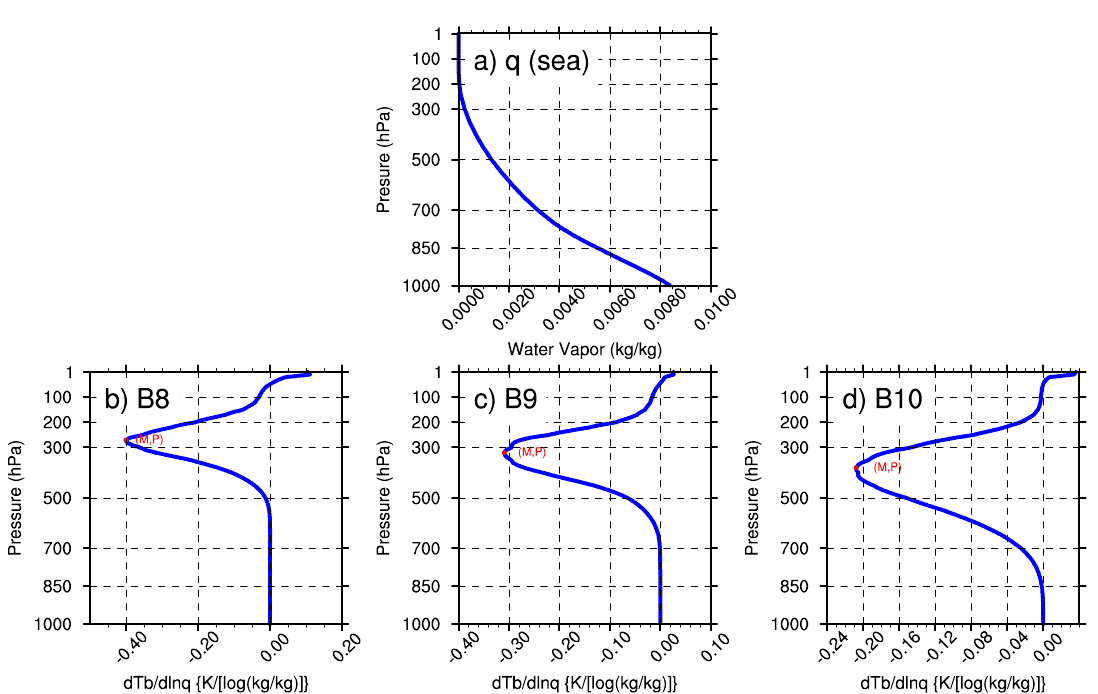
Figure 12. ( a ) The mean water vapor profile over the sea area in the typical region of East Asia. ( b )–( d ) Corresponding Jacobian functions (M) and BWIL (P) of Band 8, Band 9 and Band 10, respectively.